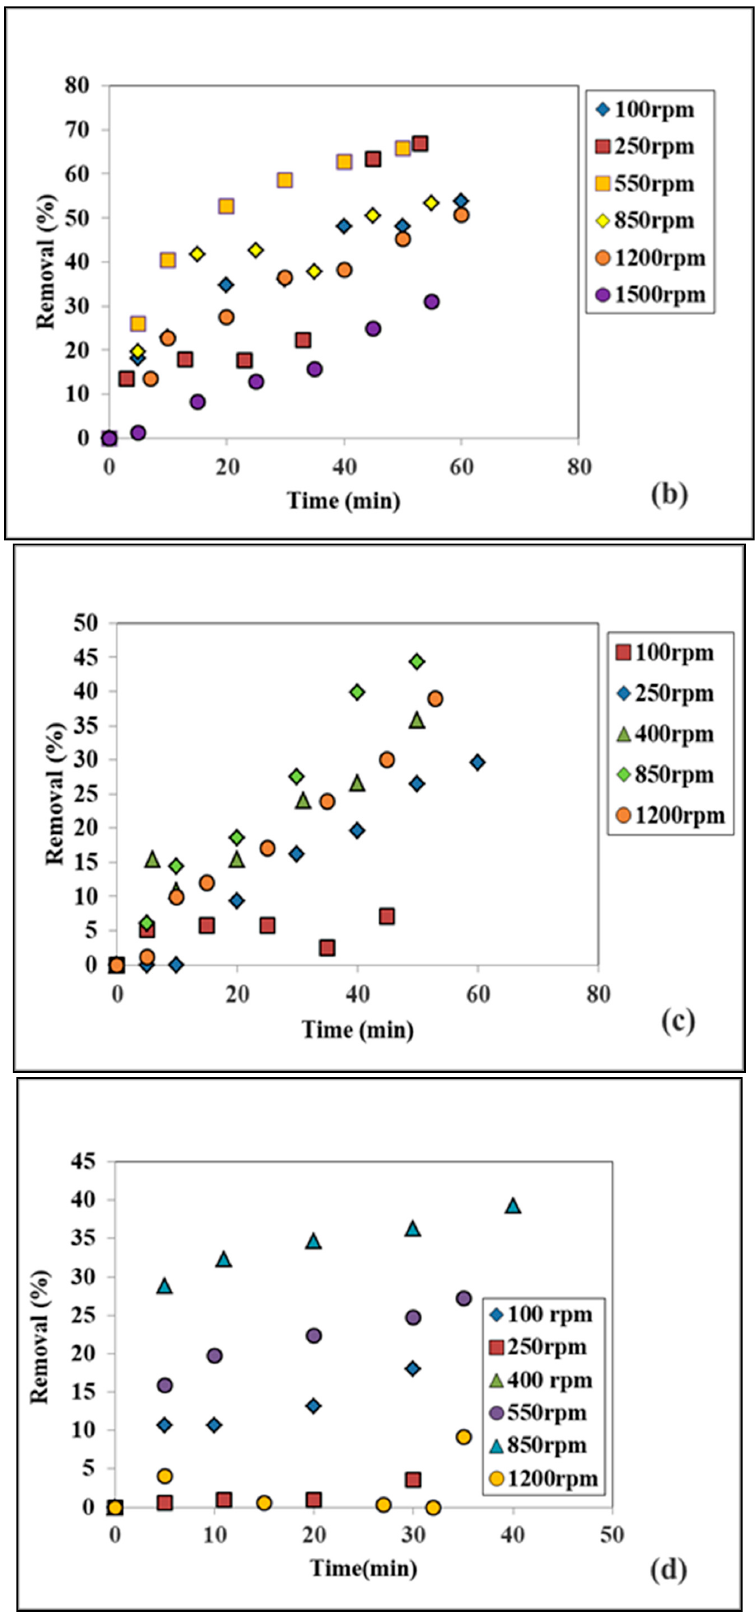
Figure 5. Disc rotating speed effect on turbidity removal, at different effluent flowrates: ( a ) 10